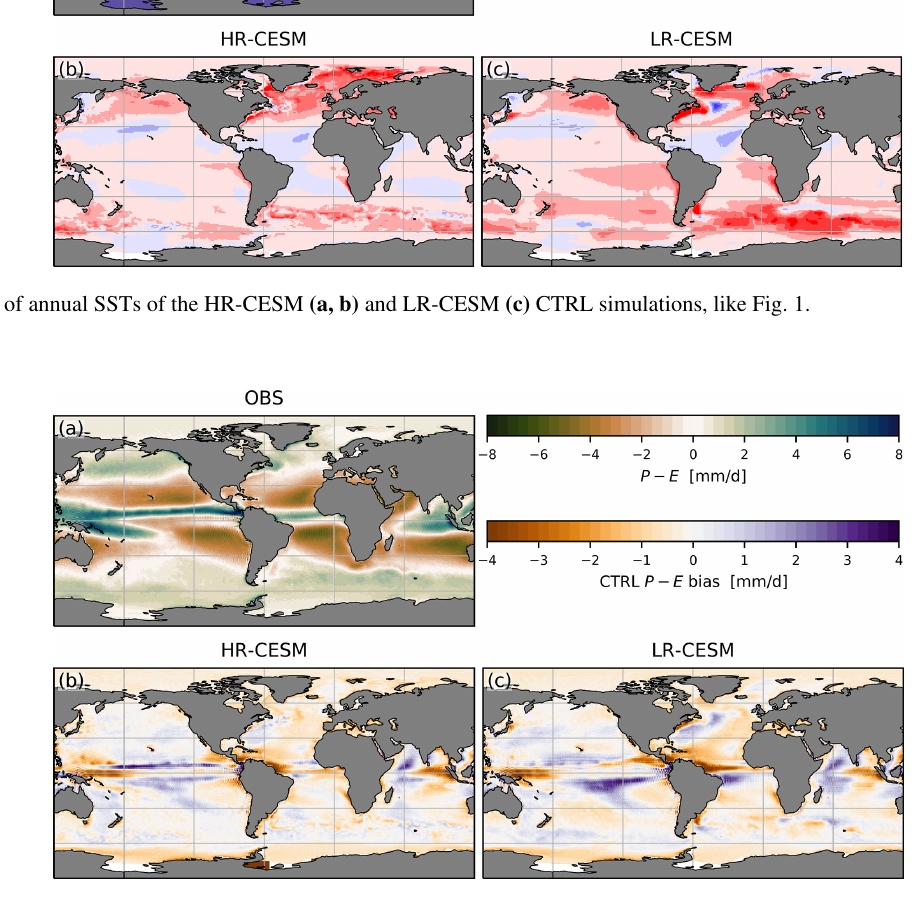
Ocean Sci., 17, 729–754, 2021